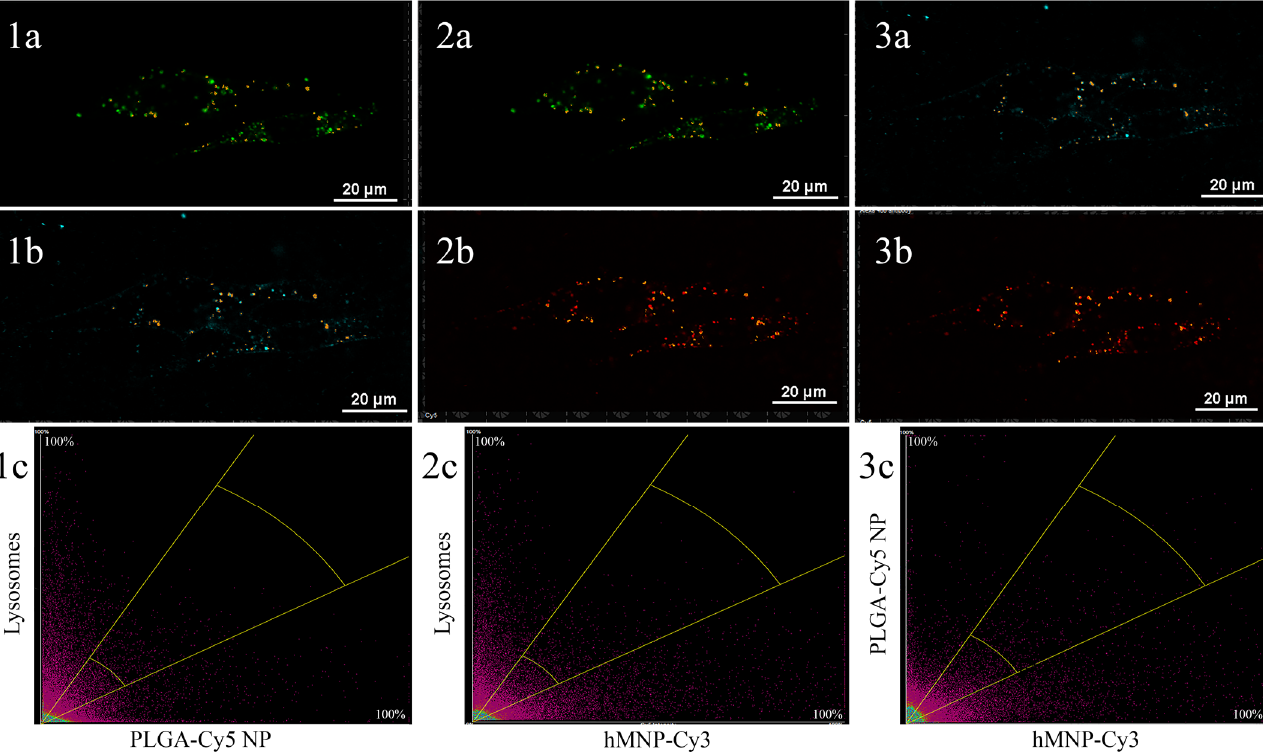
Figure 5. Investigation of nanoparticle colocalization in 4T1 cells (deconvolved image, 40 min